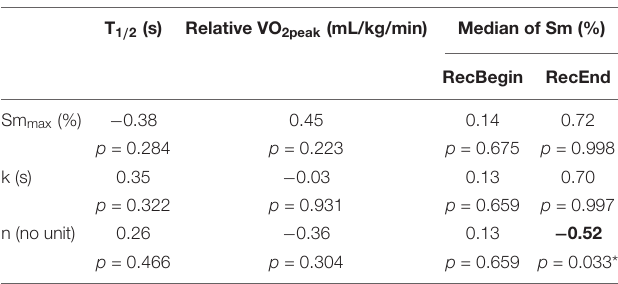
TABLE 2 | Values of linear Pearson correlation for Hill model parameters and markers characterizing the respiratory and muscular responses to the physical activity